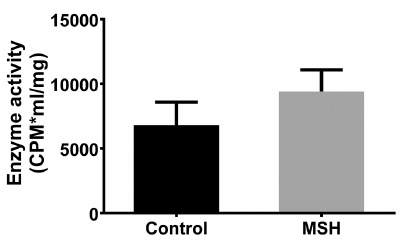
Figure 5. Effects of α -MSH treatment on NADPH stimulated NADPH oxidase activities of left ventricular tissue homogenates. Data are expressed as mean ± SEM (Student’s t -test). Samples were measured in duplicates, and the average of the averages are shown. CPM, Count Per Minute; NADPH, Nicotine adenine dinucleotide phosphate; α -MSH, α -Melanocyte-stimulating hormone